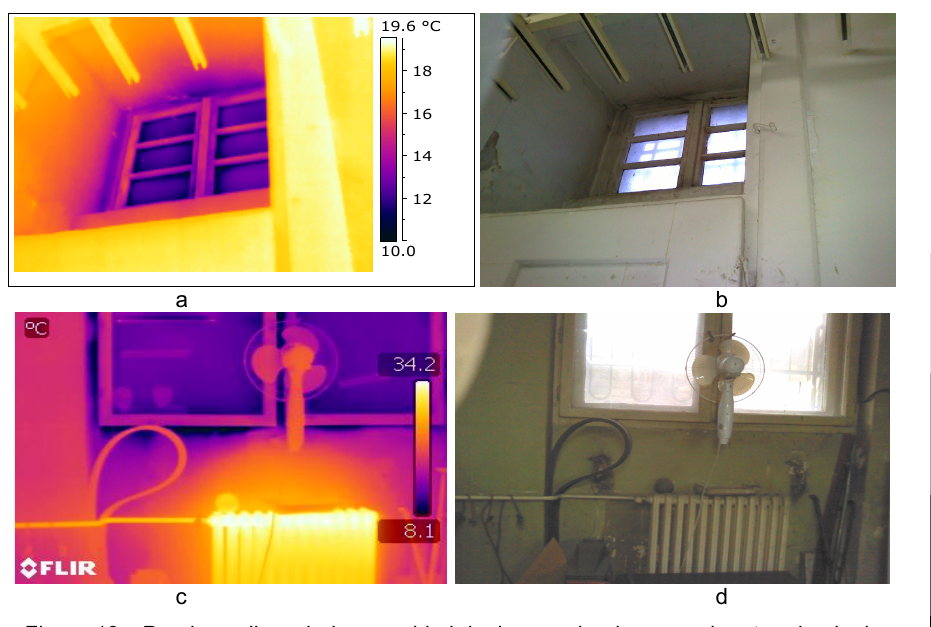
Figure 12 – Poorly sealing windows, cold air leakage, a,b – banners depot and c,d – in the workshop for metal conservation Slika 12 – Lošo zaptivanje prozora, prodor hladnog vazduha, a,b – depo sa zbirkom rat- nih zastava, c,d – radionica za konzervaciju metalnih